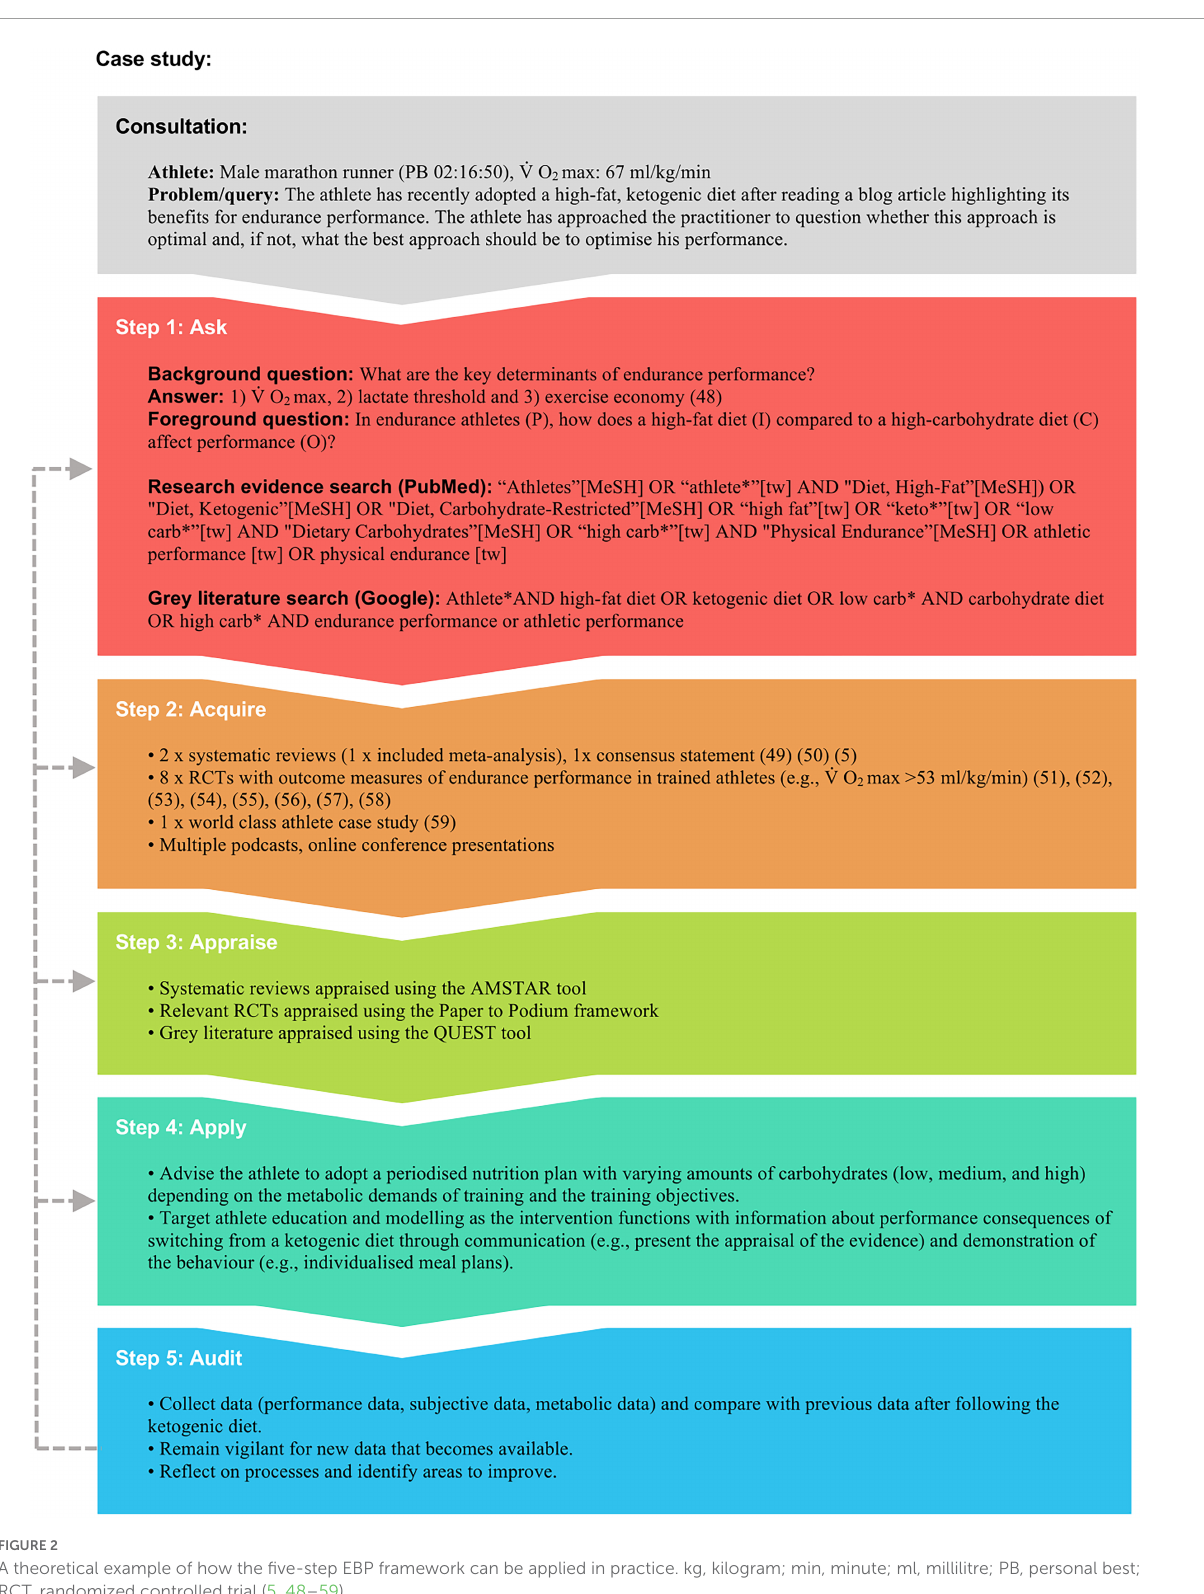
FIGURE2 A theoretical example of how the five-step EBP framework can be applied in practice. kg, kilogram; min, minute; ml, millilitre; PB, personal best; RCT, randomized controlled trial (5, 48–59).